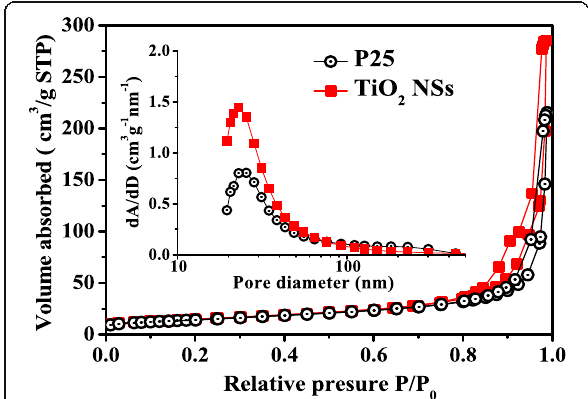
Fig. 2 Nitrogen absorption-desorption isotherms and pore size distributions (insert) of bare TiO 2 NSs and P-25